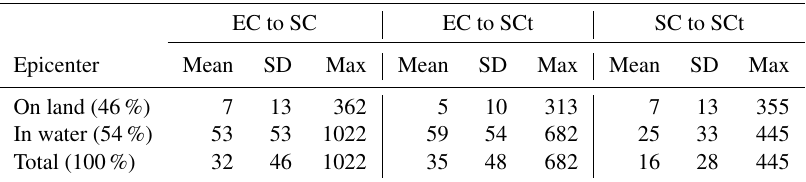
Table 1. Distances in kilometers between the epicenter (EC), shaking center (SC), and shaking centroid (SCt), by whether the epicenter is in water or on land for all 11510 events with shaking and magnitude greater or equal 4.5.